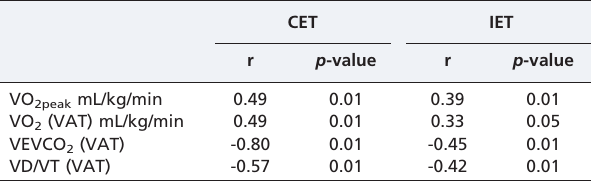
Table 3 - Correlations between PETCO 2 at ventilatory anaerobic threshold and the cardiorespiratory measurements in CAD patients after continuous exercise training and interval exercise training.